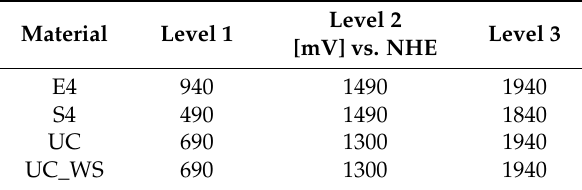
Table 2. Potentiostatic potentials on level 1, 2 and